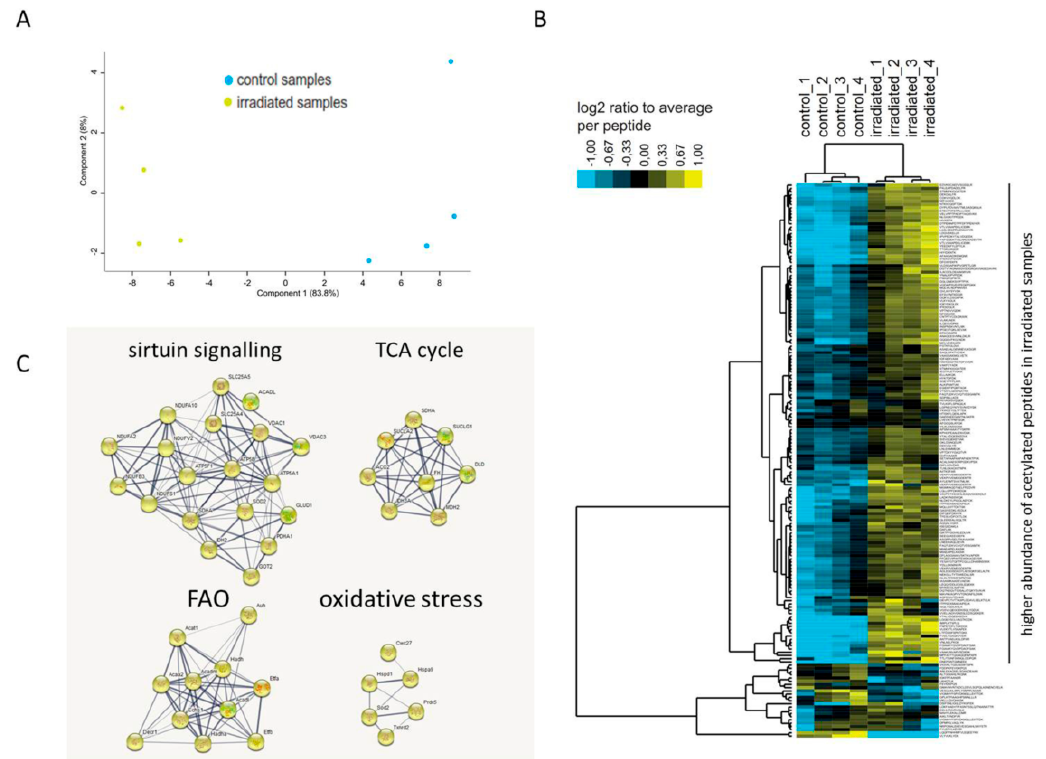
Figure 2. Protein-protein interaction analysis of acetylated proteins changed following total body irradiation. Principal component analysis (PCA) based on all acetylated peptides features ( A ). Heat map showing higher abundance of acetylated peptides (in yellow) in irradiated samples compared to the controls ( B ). Protein–protein interactions are analyzed by the STRING software tool (http://string-db.org) indicating the most affected protein clusters ( C ).